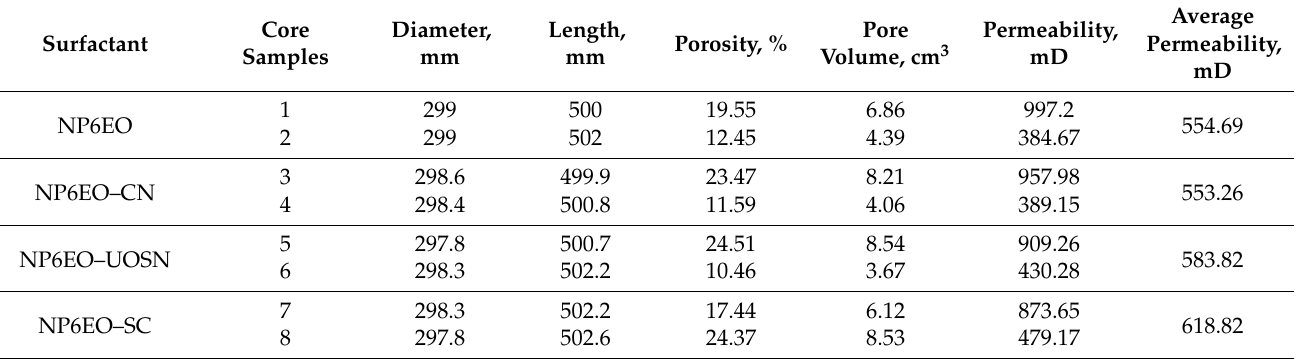
Table A1. Core for filtration experiment.